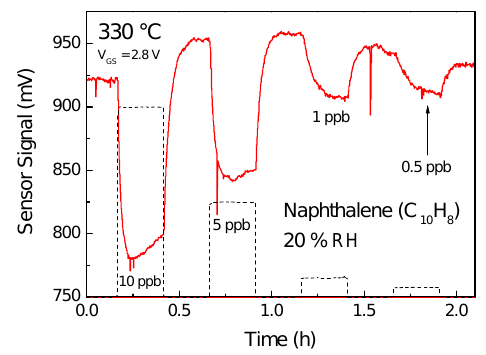
Figure 8. Effect of relative humidity on the sensor response to formaldehyde (CH 2 O) from 1ppm to 0.2ppb at 330 ◦ C.